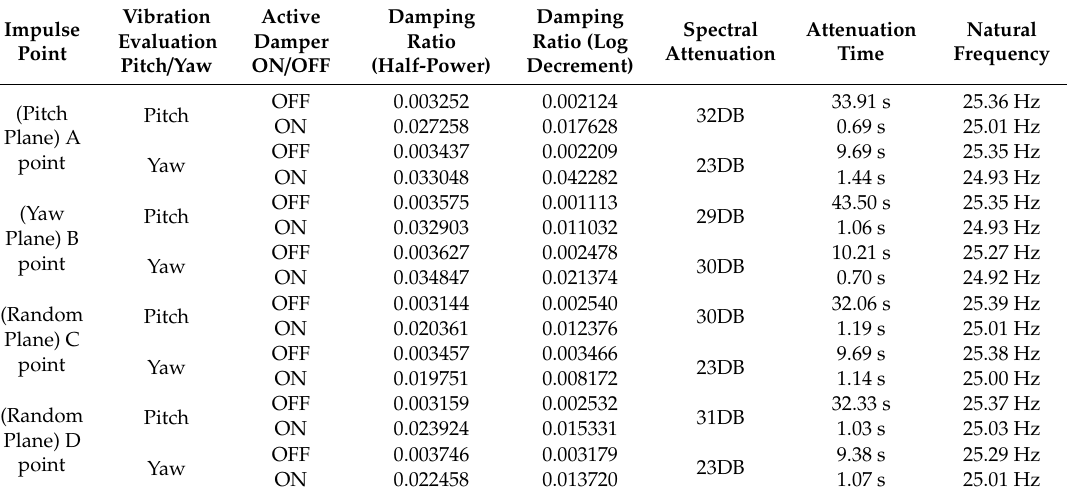
Table 2. Verification results in lab.